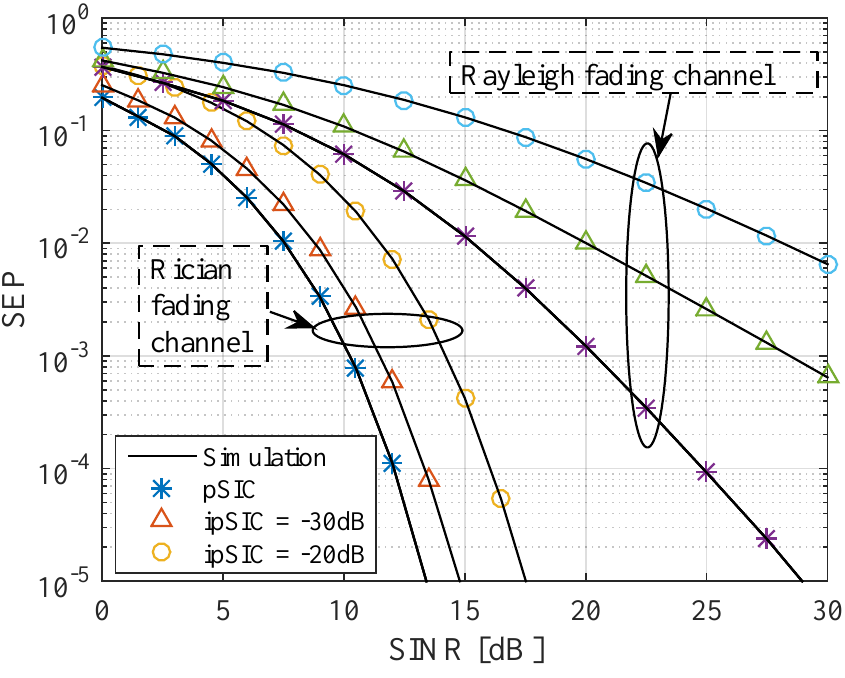
Figure 6. Symbol error probability of STBC-NOMA with U = 4 for imperfect SIC, and perfect timing synchronization over Rayleigh and Rician fading channels with K = 4